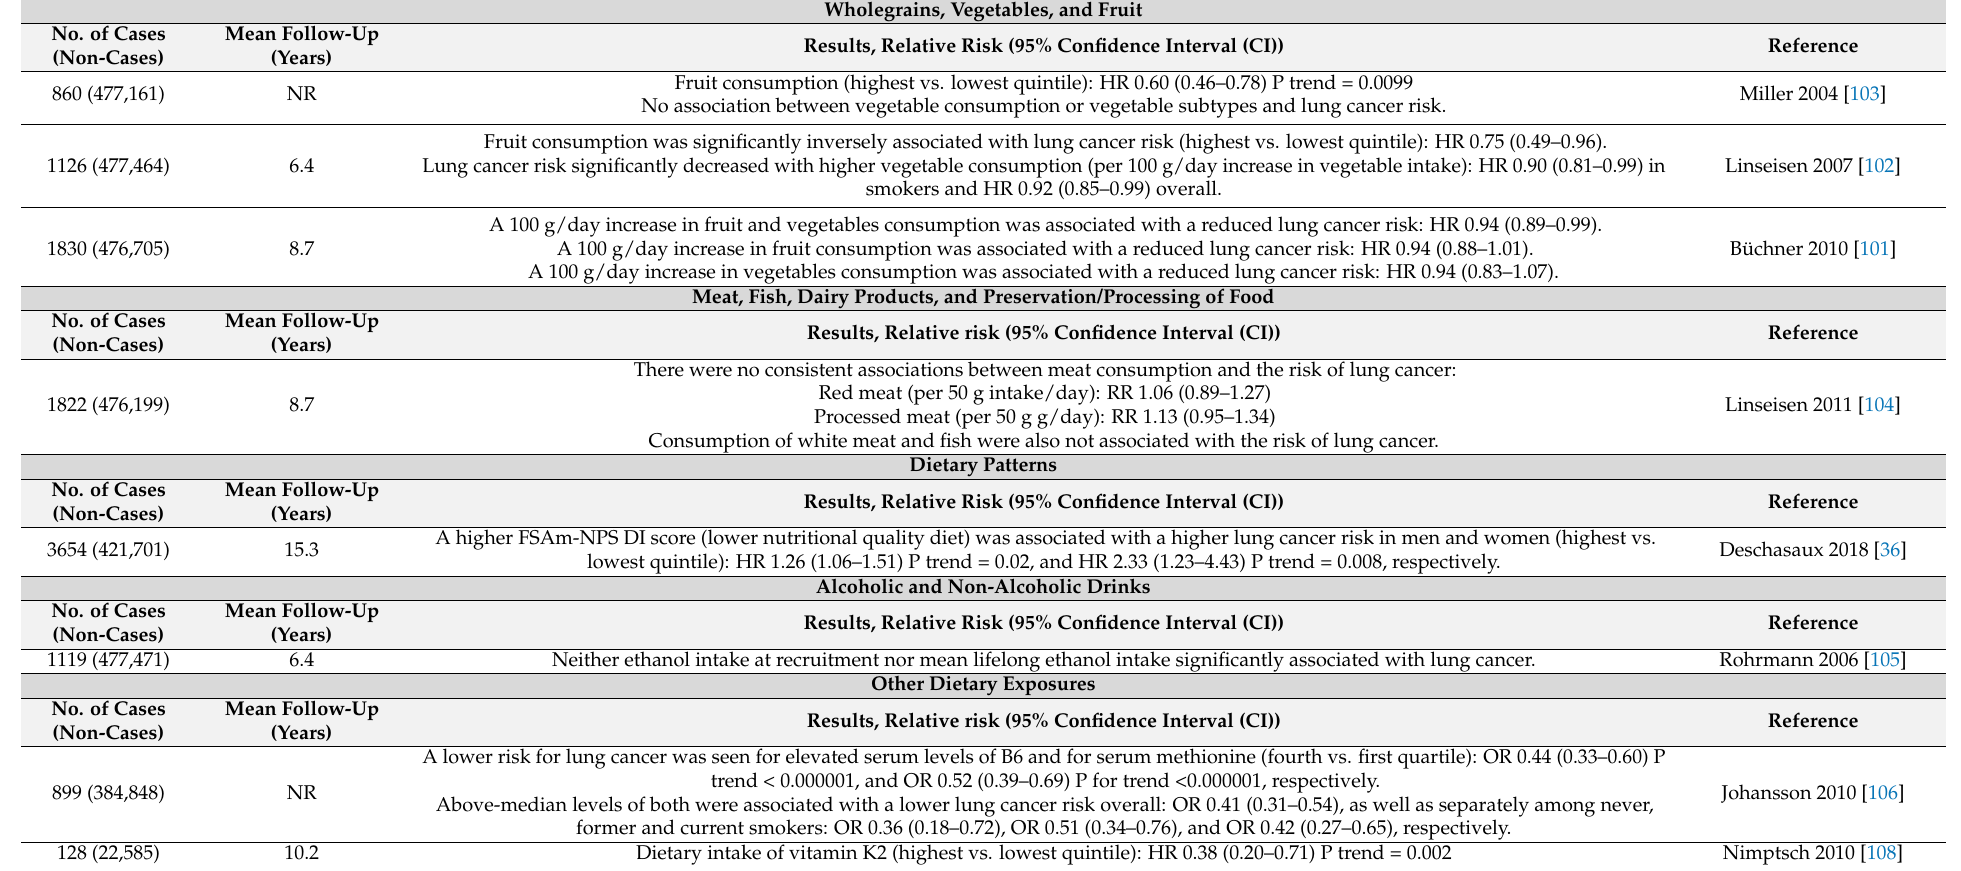
Table 3. Evidence synthesis of the association between diet and lung cancer in the EPIC study. Wholegrains, Vegetables, and Fruit